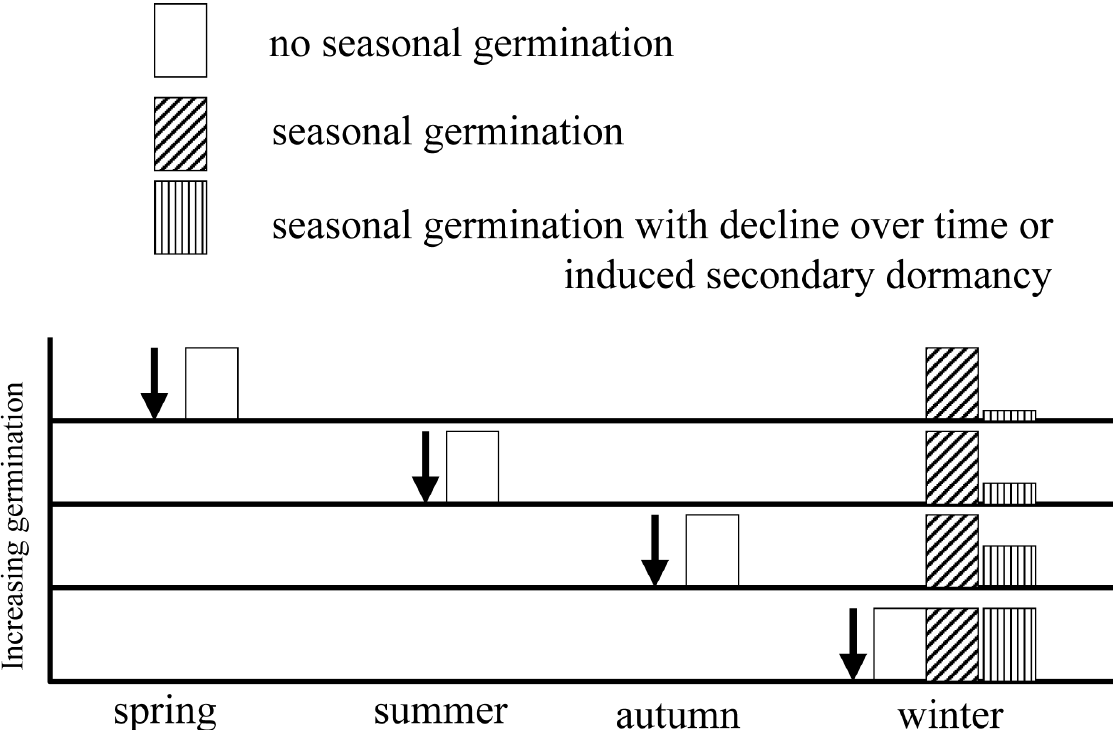
Fig. 2. Impact of season of burn on resultant seedling germination for three classes of species: no seasonal germination impacts (open bars); seasonal germination (sloped hatching); and seasonal germination that declines with the length of time since fire with respect to the favourable season for germination (vertical hatching). Arrows represent four postulated fires (one for each season). The germination level after fires in different seasons is staggered for